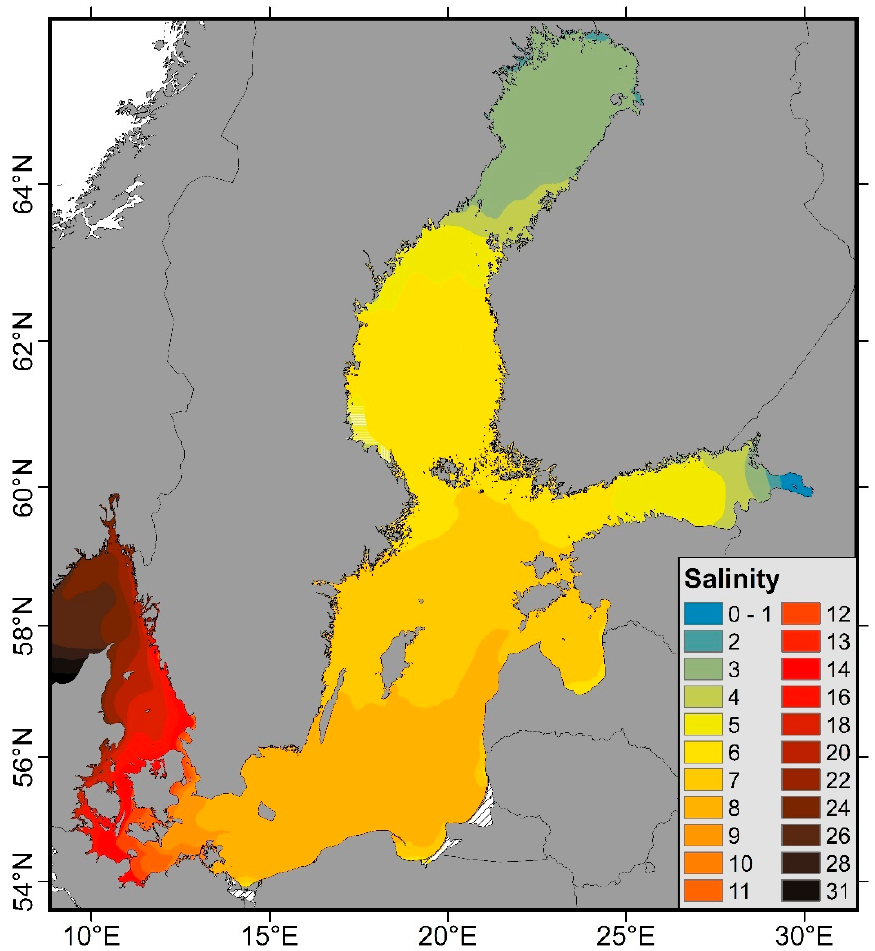
Figure 1. Five-year average (2015–2019) of the sea surface salinity (1.5 m) indicating the extended salinity gradient of the Baltic Sea, obtained from hydrodynamic modelling (data from Lehmann et al. [18]).